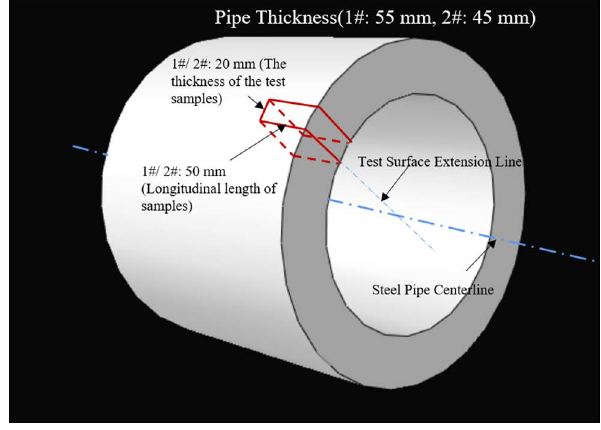
Figure 1. A diagram showing the sampling location from the steel pipes were sampled.